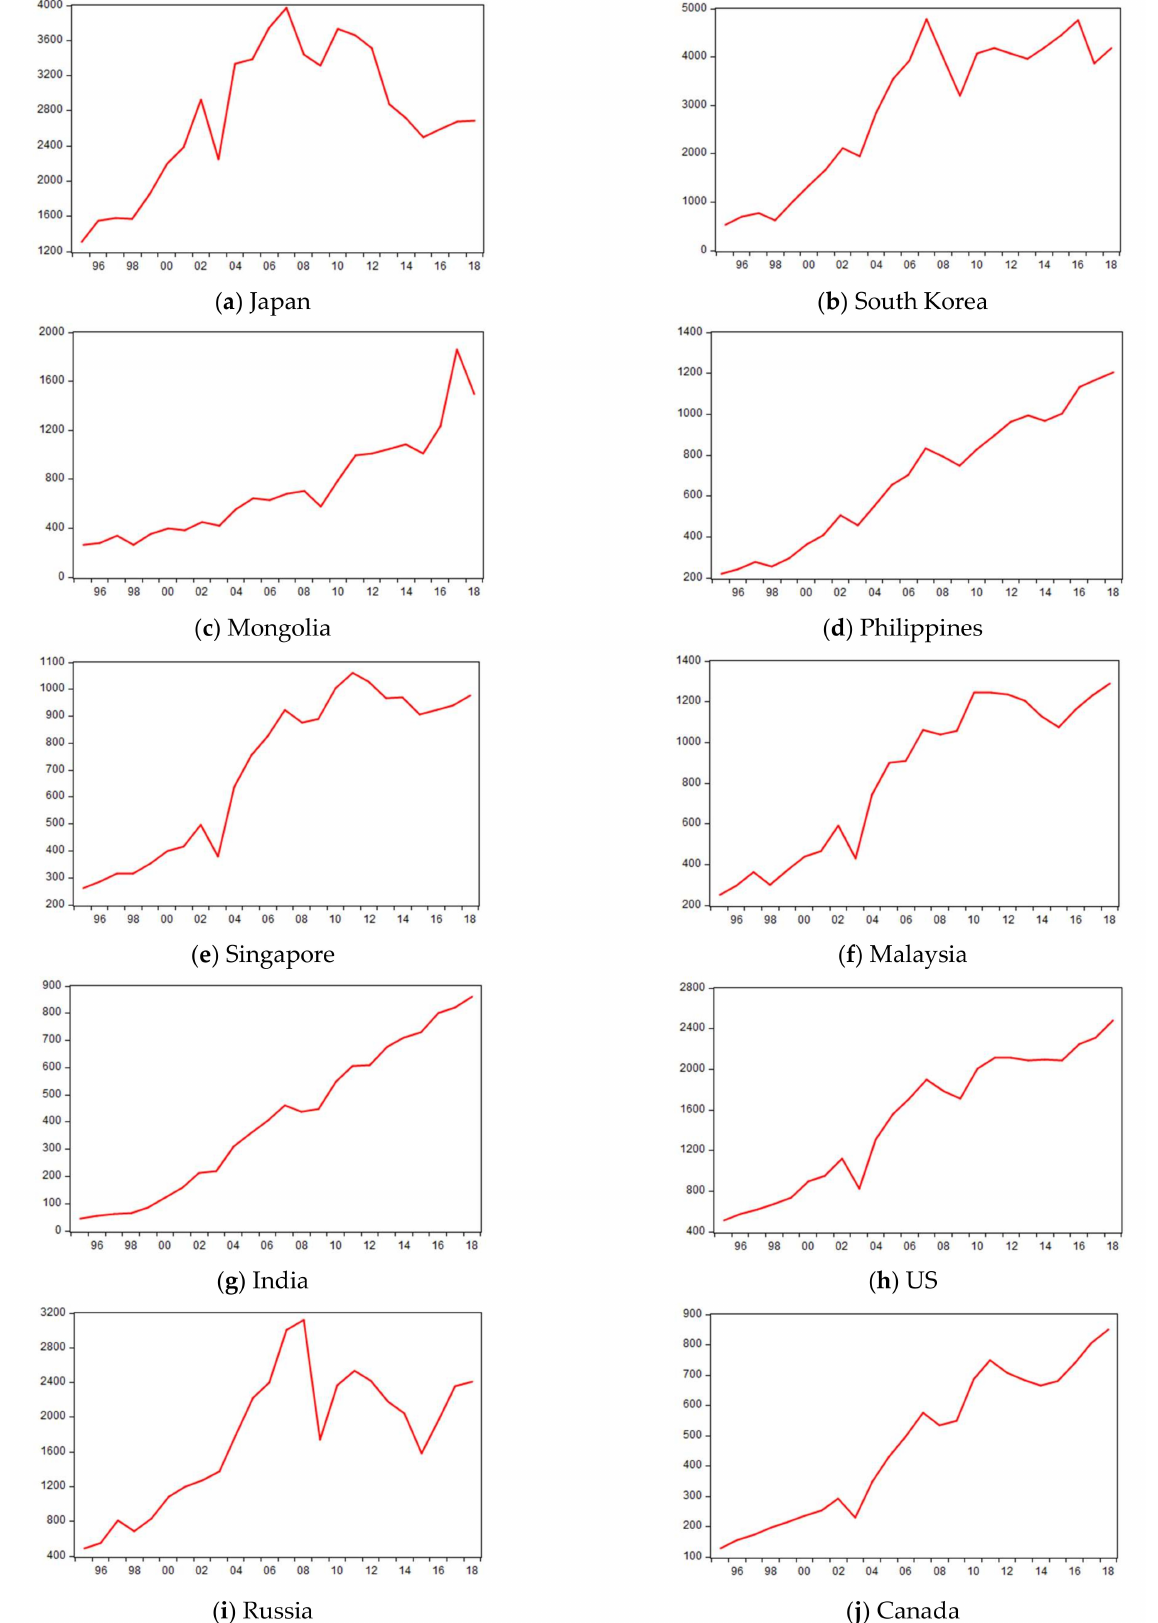
Figure 1. Tourist arrivals to China. Source: CEIC